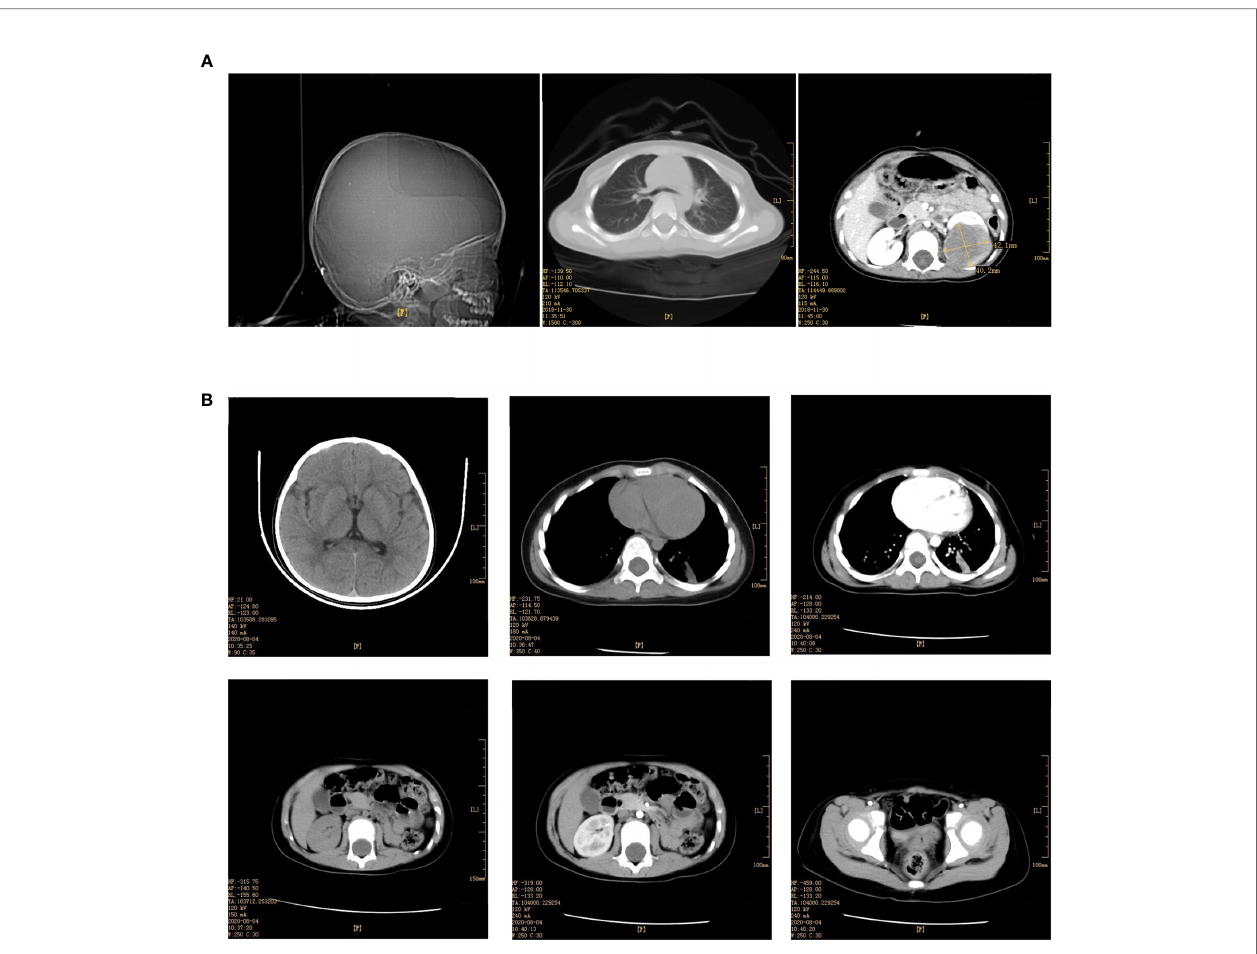
FIGURE 1 | (A) Enhancement of skull, chest, whole abdomen CT plain scan before the operation (December 03, 2018). (B) Enhancement of skull, chest, whole abdomen CT plain scan after the operation (August 04,